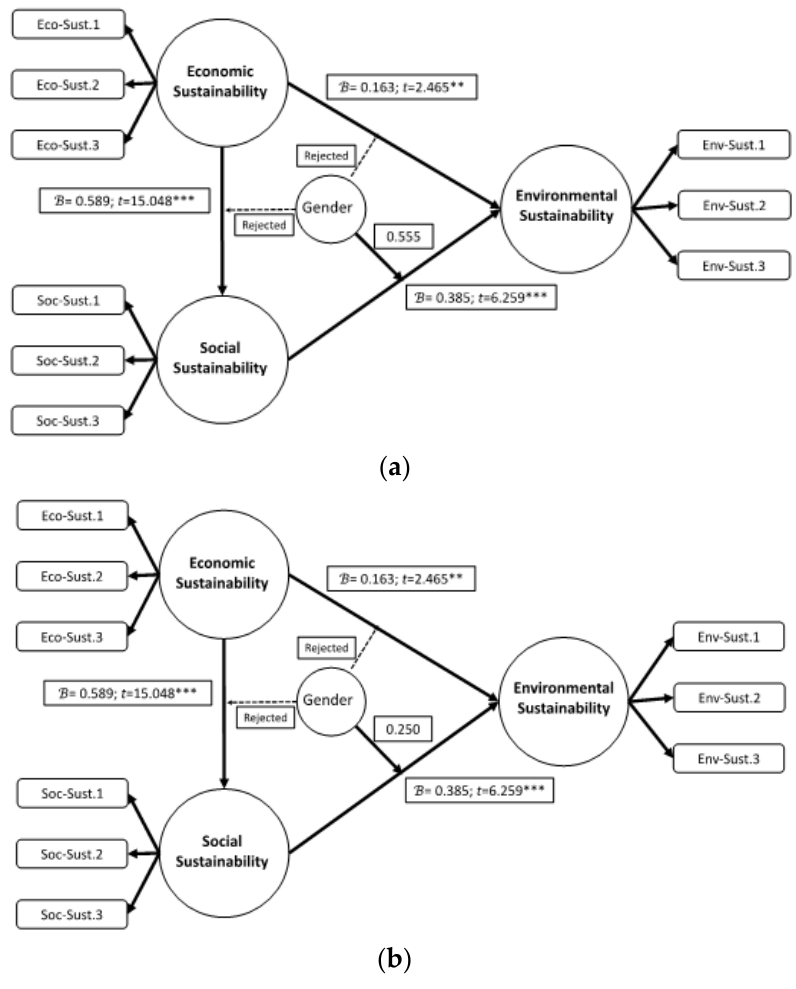
Figure 2. Final model. Results of assessment of model in men ( a ) and women ( b ). ** p -value < 0.01; *** p -value < 0.001